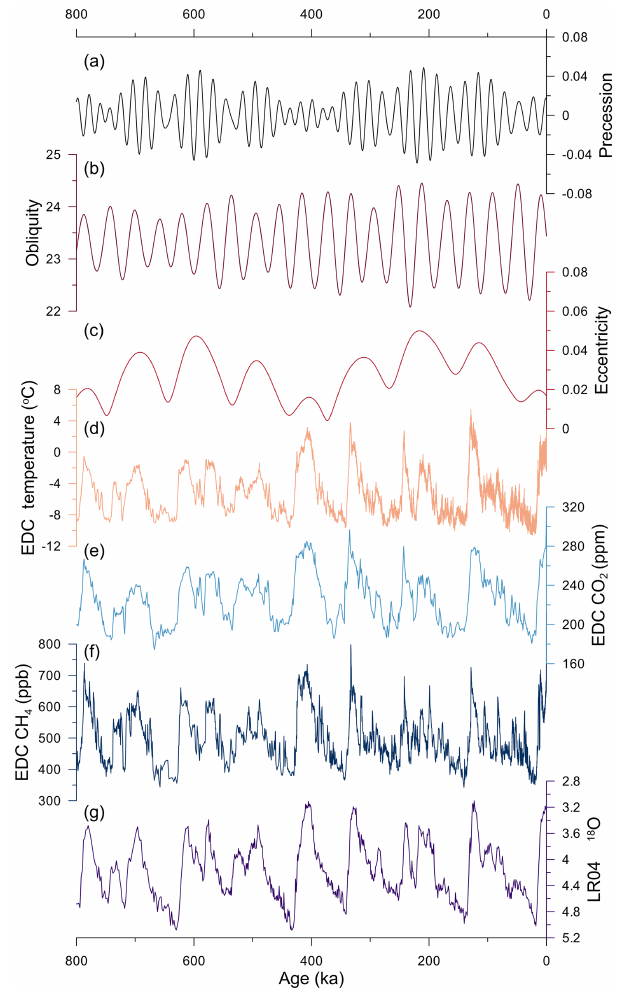
Figure 1. Orbital forcing and climate records for the last 800kyr. (a, b, c) Precession, obliquity, and eccentricity (Laskar et al., 2004). (d) Deuterium-derived temperature from the European Project for Ice Coring in Antarctica (EPICA) Dome C ice core in Antarc- tica (Jouzel et al., 2007). (e) Atmospheric CO 2 from EPICA Dome C (EPICA-community-members, 2004; Lüthi et al., 2008). (f) Atmospheric CH 4 from EPICA Dome C (EPICA-community- members, 2004). (g) Global benthic oxygen isotope stack (Lisiecki and Raymo,